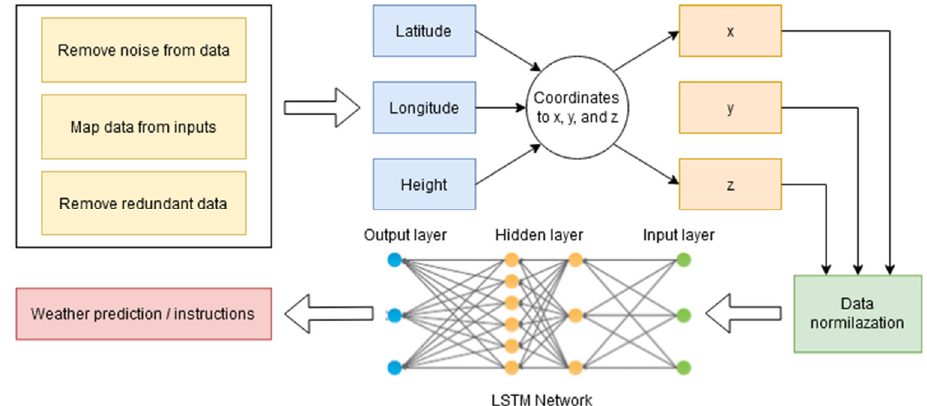
Figure 12. Proposed model for aircraft dynamics simulation.